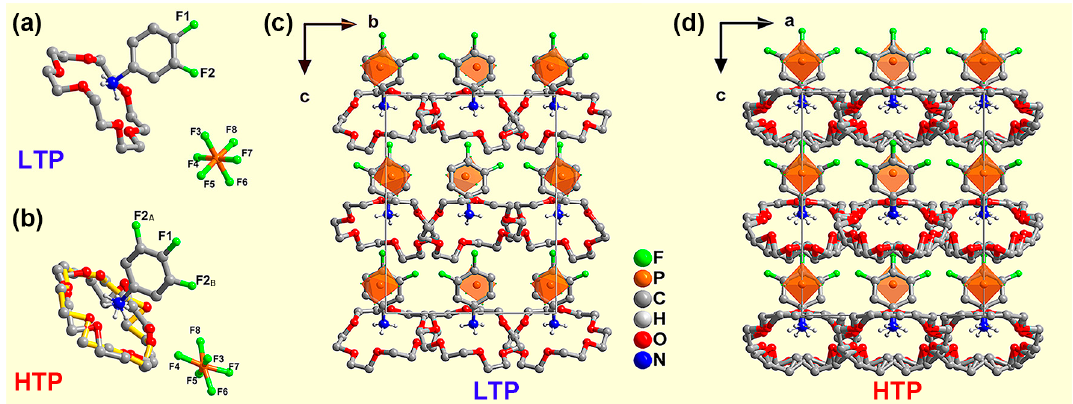
Figure 2. ( a ) The asymmetric units of 1 in low-temperature phase (LTP). ( b ) The asymmetric units of 1 in high-temperature phase (HTP). The disordered parts in ( b ) are distinguished by different bond colors. ( c ) The crystallographic packing diagrams of 1 in LTP. ( d ) The crystallographic packing diagrams of 1 in HTP.